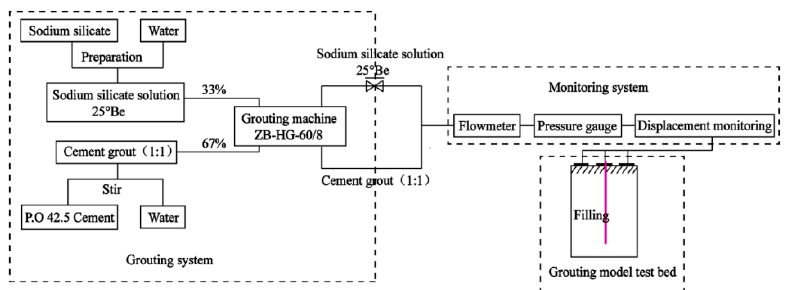
Figure 1. Structure diagram of the test system.